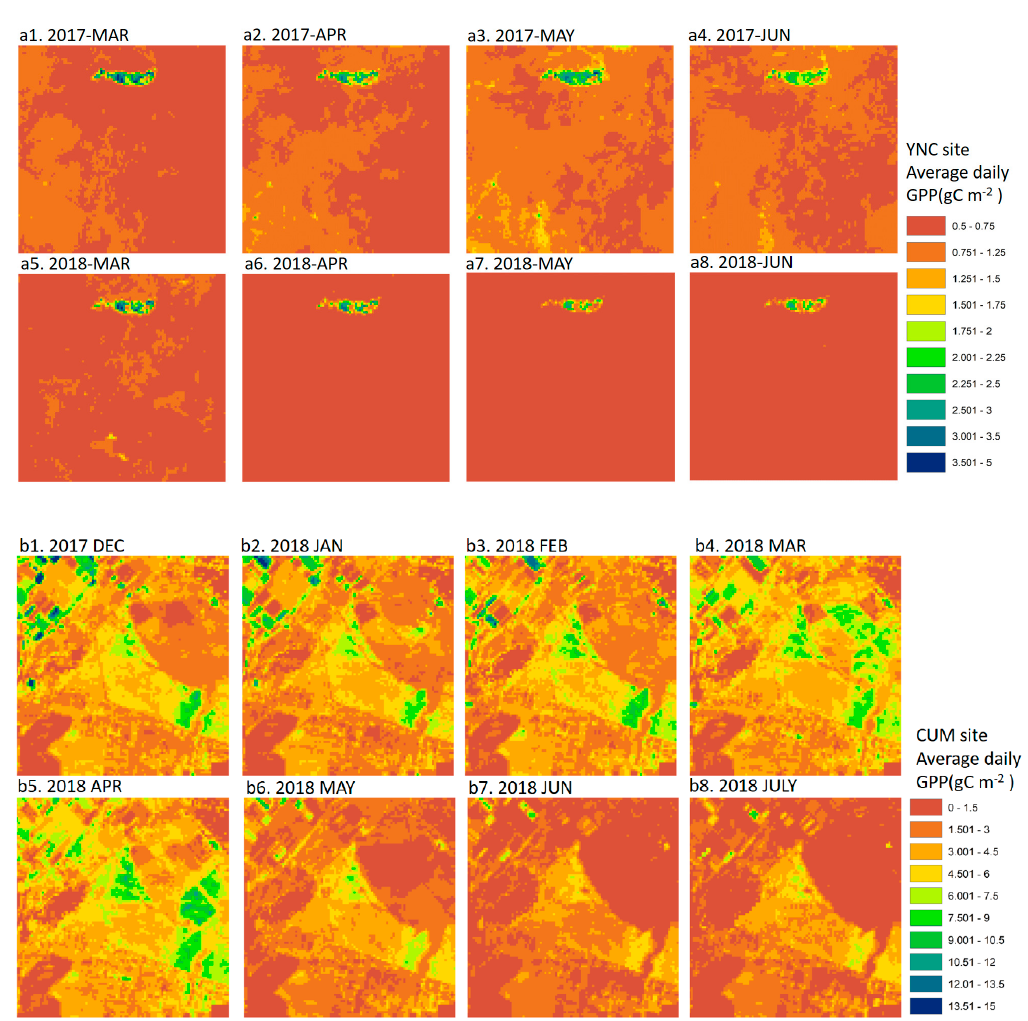
Figure 10. Temporal trends in GPP spatial distribution at the YNC (a1–a8) and CUM (b1–b8) sites. The GPP estimation of each subfigure is based on the CIr–PARin–GPP relationship shown in Tables 3 and 4